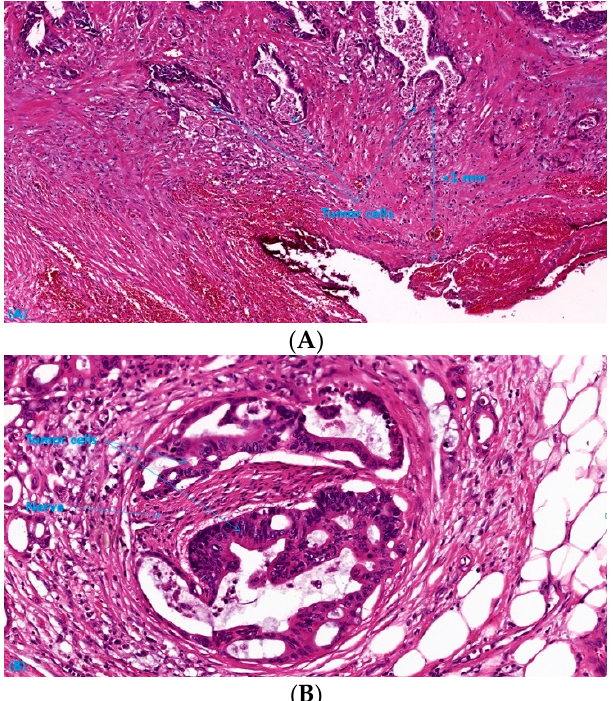
Figure 1. ( A ) Microscopic tumor involvement within 1 mm of the circumferential resection margin (hematoxylin and eosin stain; original magnification ×100) ( B ) Perineural invasion of tumor cells (hematoxylin and eosin stain; original magnification ×200).